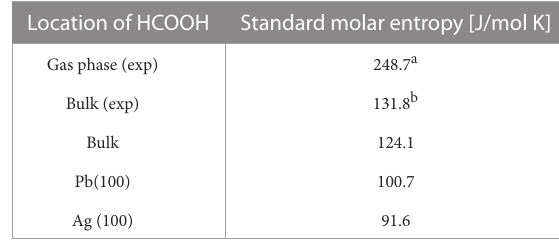
TABLE7 StandardmolarentropiesofHCOOHinbulksolutionandat thePb(100)andAg(100)surfaces.Allentropyvaluesexceptthe